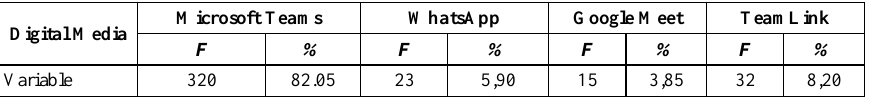
Table 2. Distribution of university students according to the digital media used in the distance education